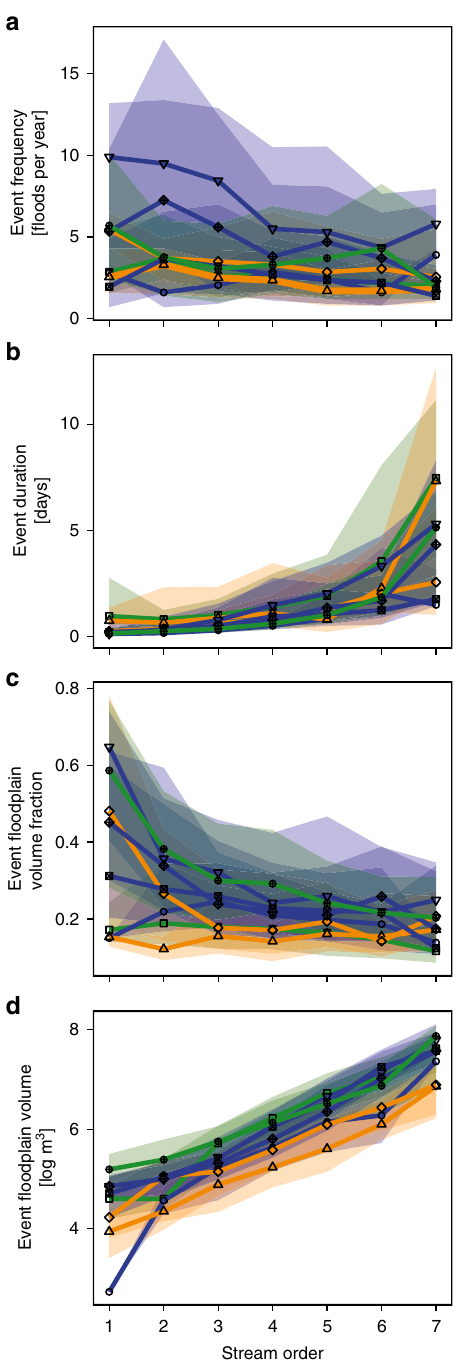
Fig. 2 Flood characteristics as a function of stream size. Median ( a ) event frequency [ fl oods year − 1 ], ( b ) event duration [days], ( c ) fraction of fl ood that inundates fl oodplain, and ( d ) event fl oodplain inundation volume [log10 m 3 ]. The shading represents the 25th and 75th quartiles of the stations within each major river basin of a given stream size (small — 1st order to large — 8th